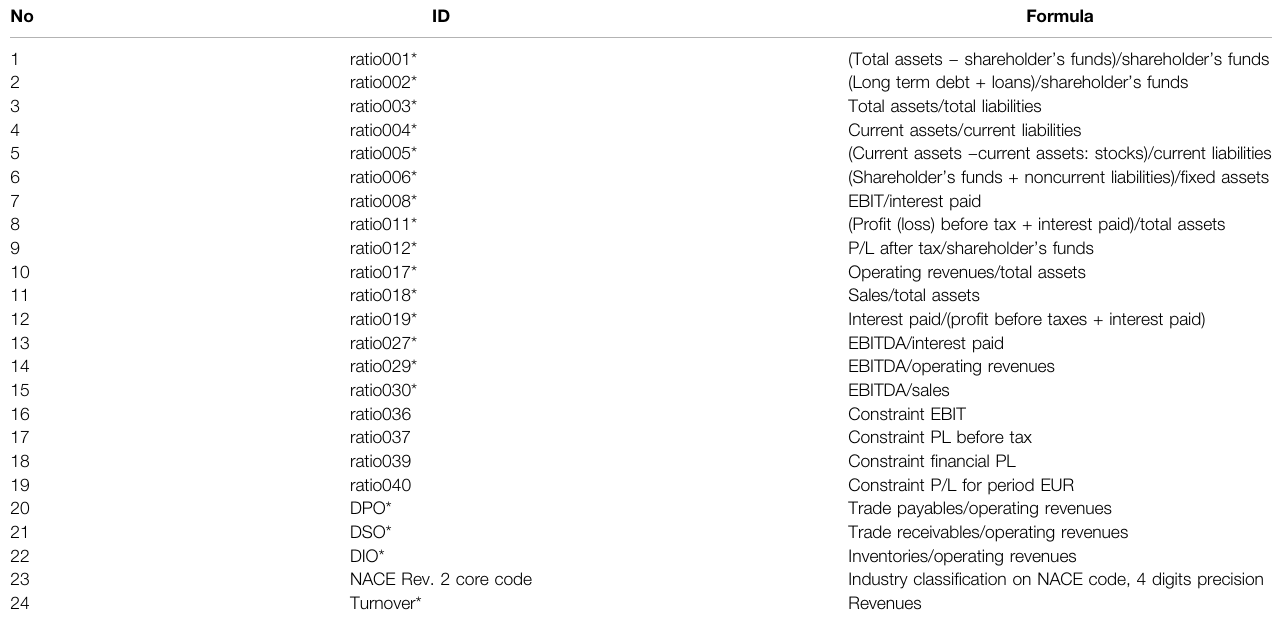
TABLE 1 | List of the 24 loan features, with their respective descriptions. Only features marked with * are used as discriminators. No